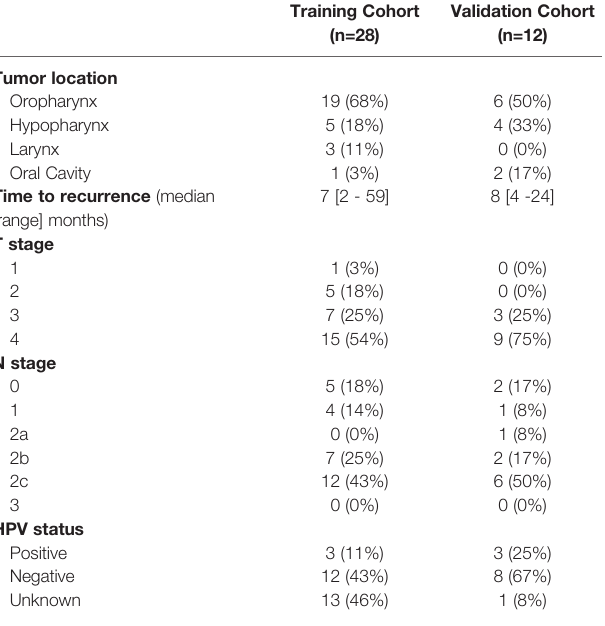
TABLE 1 | Patient characteristics of all included